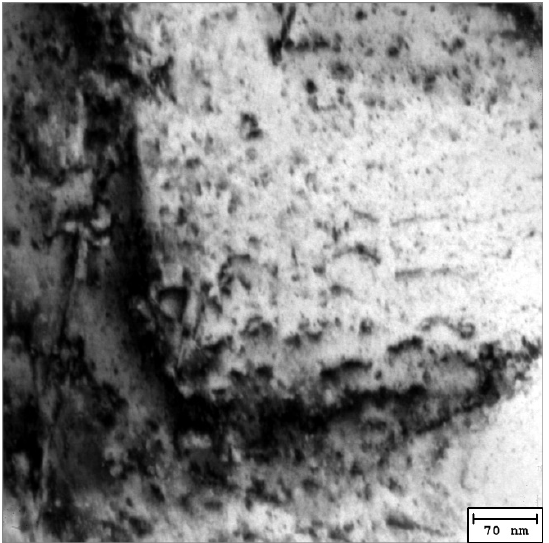
Figure 8. Precipitated particles in the Fe-25Mn-3Si-3Al-0.3Nb steel after solution treatment.